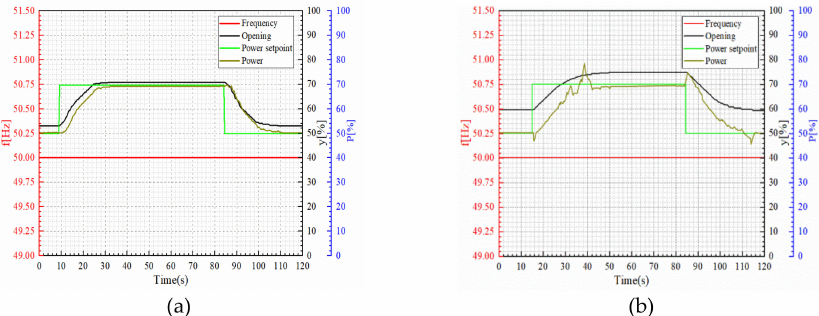
Figure 10. Power regulation with 20% rated power change. ( a ) The S-curve control strategy; ( b ) The conventional linear control strategy.